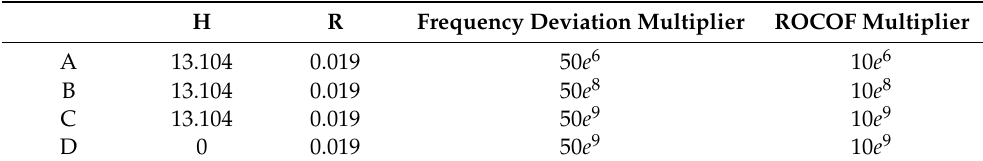
Table 5. WT control and BESS gain parameters.